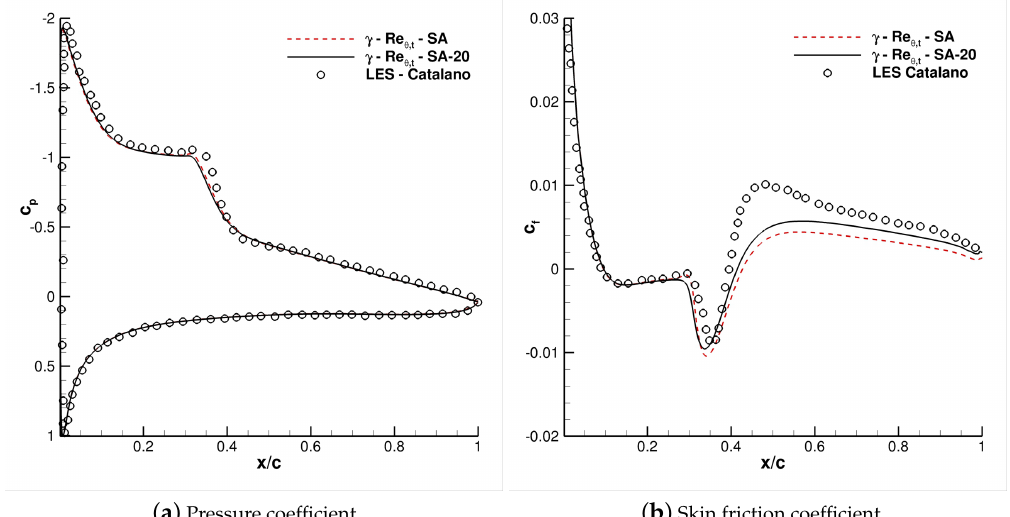
Figure 2. SD7003, Re = 6 × 10 4 . α = 6 ◦